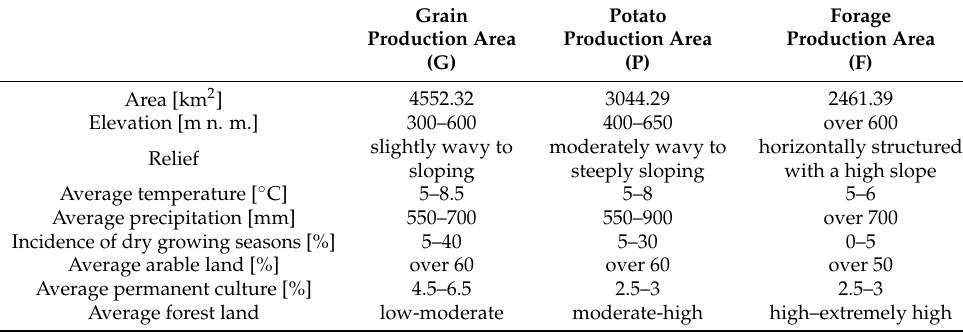
Figure 1. Map of selected cadastral territories. Table 1. Characteristics of production areas in the South Bohemian region according to